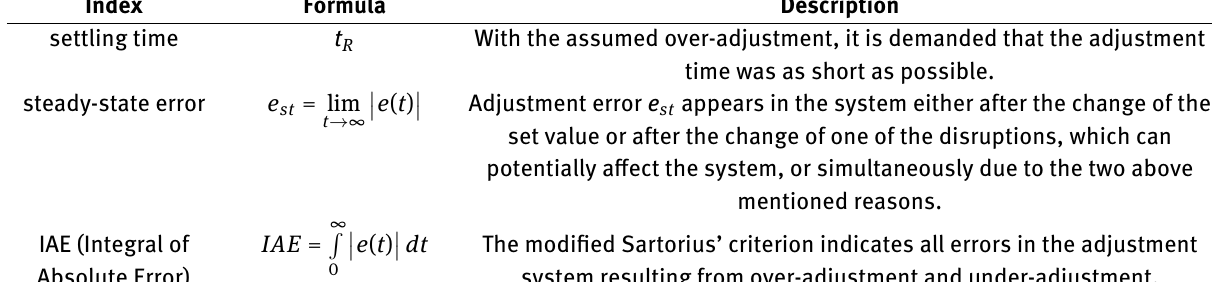
Table 3: Performance indices.